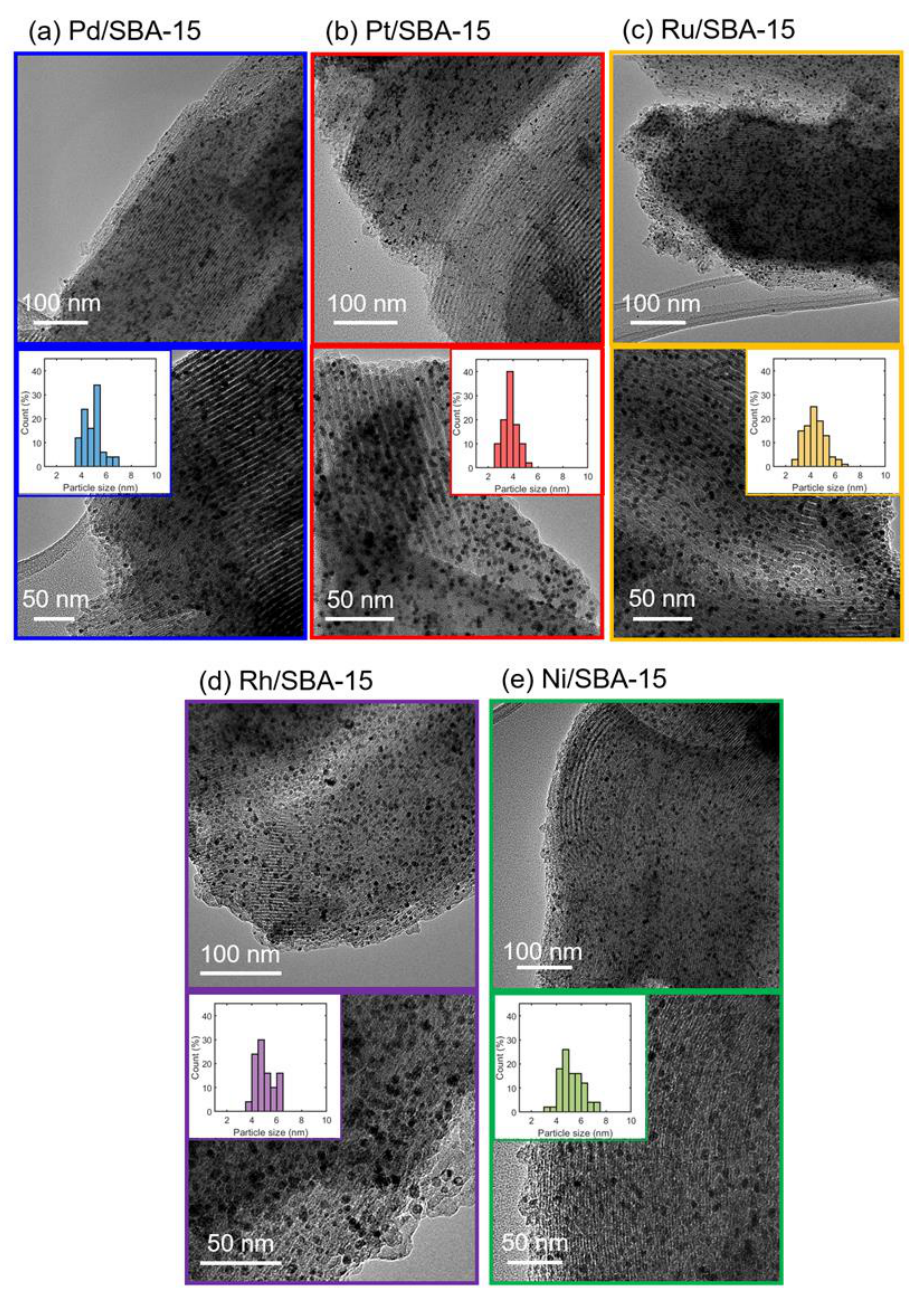
Figure 1. Representative TEM images of ( a ) Pd/SBA-15 (high loading), ( b ) Pt/SBA-15, ( c ) Ru/SBA-15, ( d ) Rh/SBA-15, and ( e ) Ni/SBA-15. The insets show the corresponding particle size distributions.